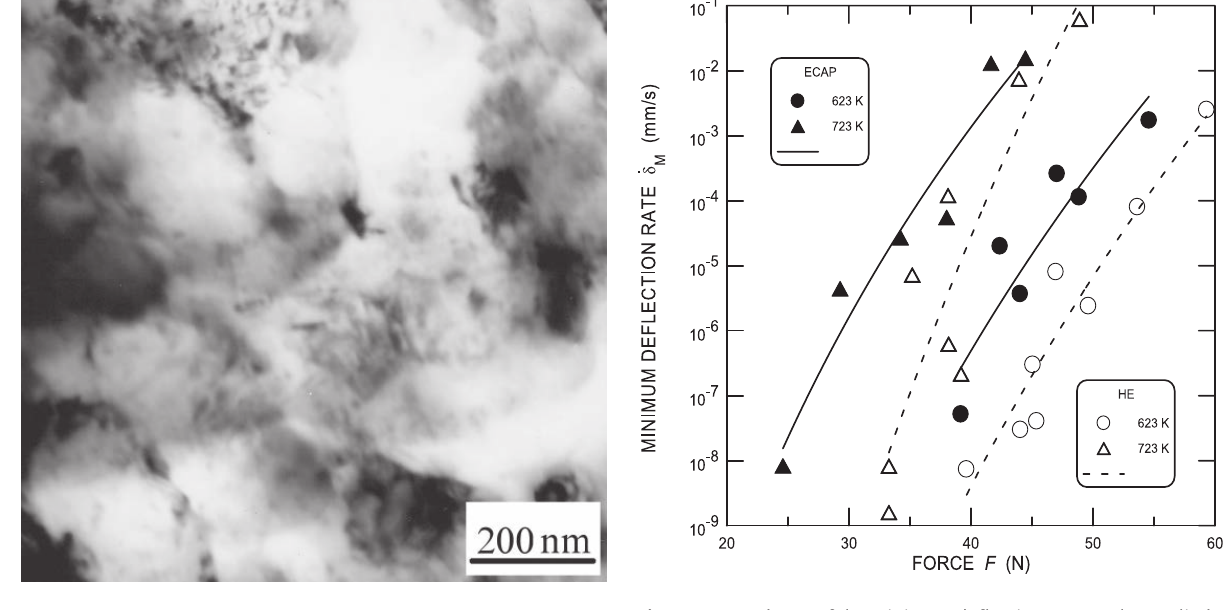
( − 36.59 at 623 K and − 32.71 at 723 K, respectively). The